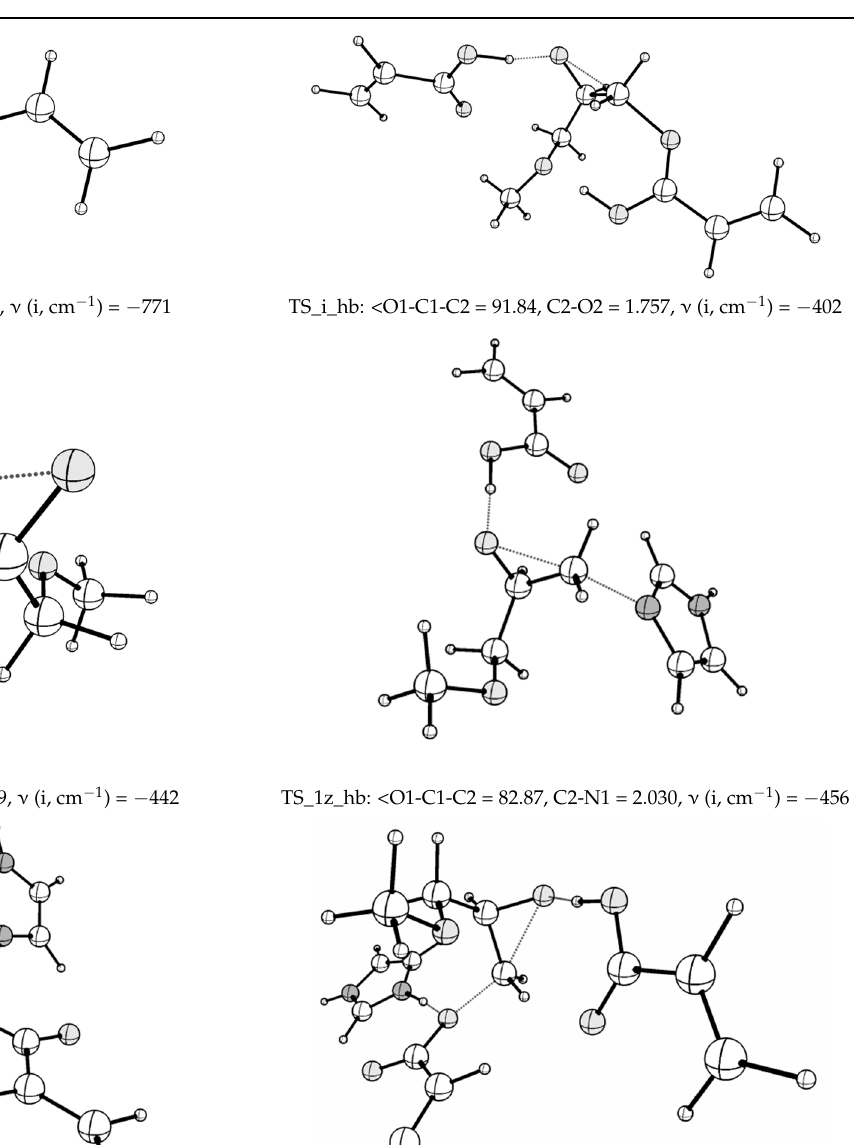
Table 4. Transition states involved in proposed mechanisms.